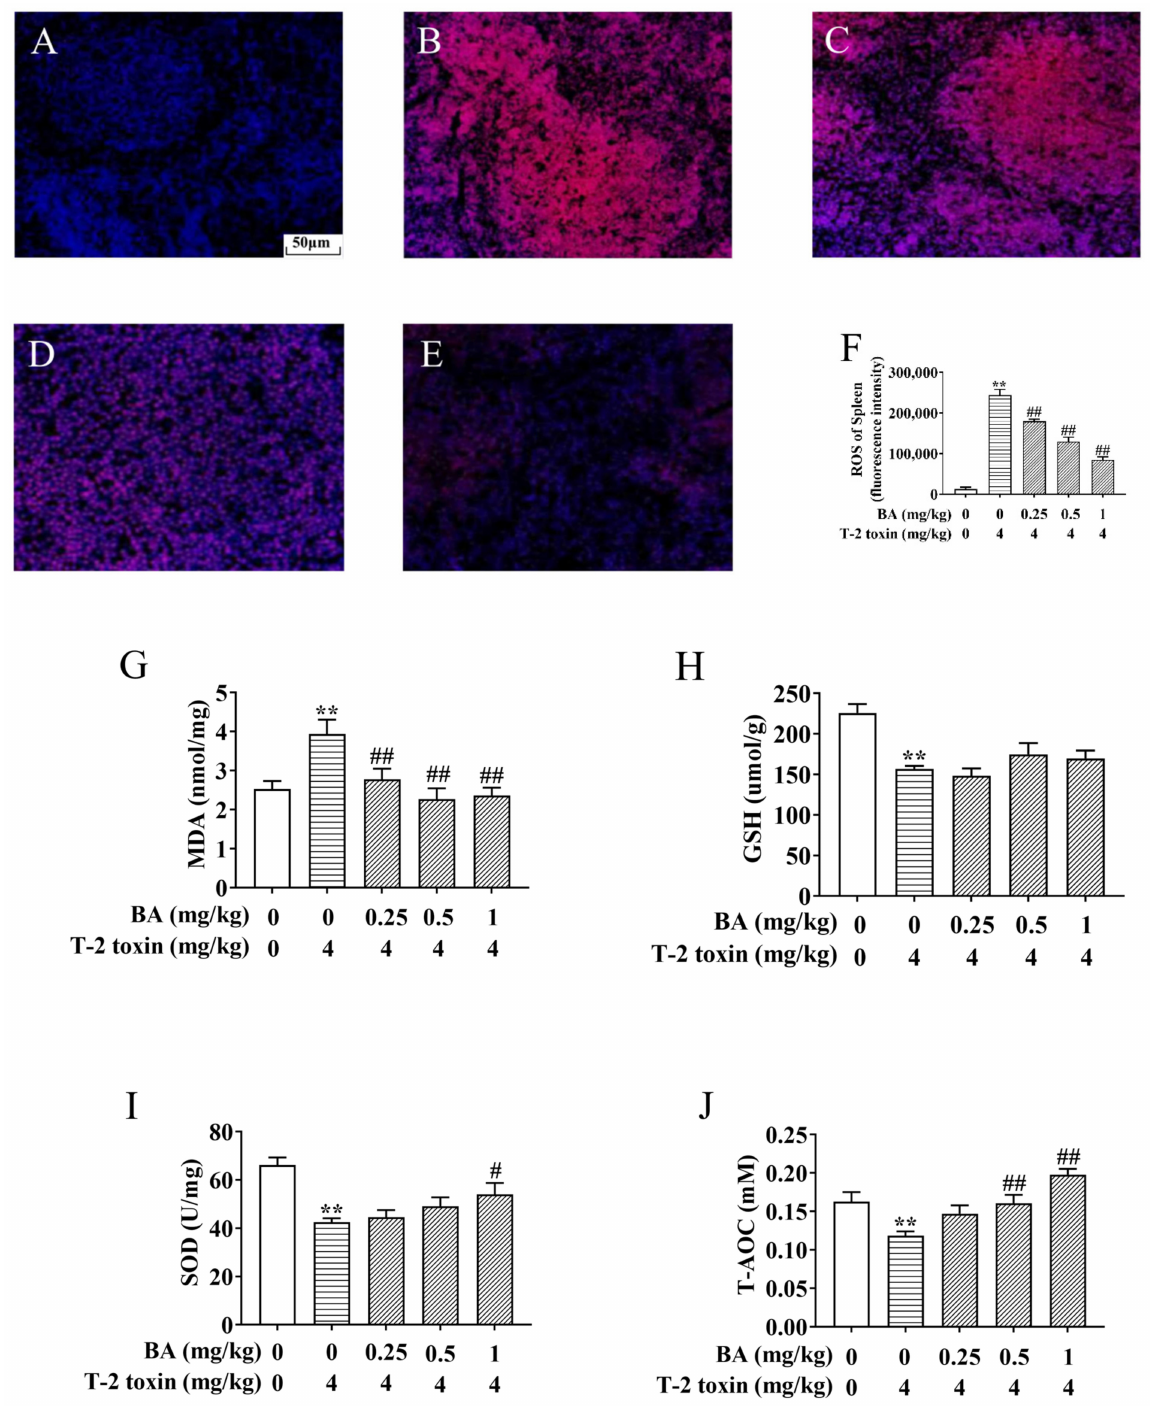
Figure 3. BA protects against T-2 toxin-triggered spleen oxidative stress. The reactive oxygen species (ROS) level in the spleen was determined by a fluorescence microscope using dihydroethidium (DHE). Notes: control group ( A ), T-2 toxin group ( B ), 0.25 mg/kg BA + T-2 toxin group ( C ), 0.5 mg/kg BA + T-2 toxin group ( D ), and 1 mg/kg BA + T-2 toxin group ( E ). Scale bar, 50 µ m. Quantitative analysis of ROS level ( F ). The levels of malondialdehyde (MDA) ( G ), glutathione (GSH) ( H ), superoxide dismutase (SOD) ( I ), and total antioxidant capacity (T-AOC) in the spleen, ( J ) Data were presented as the mean ± SEM (10 mice per group). ** p < 0.01 vs. the control group. # p < 0.05 and ## p < 0.01 vs. the T-2 toxin